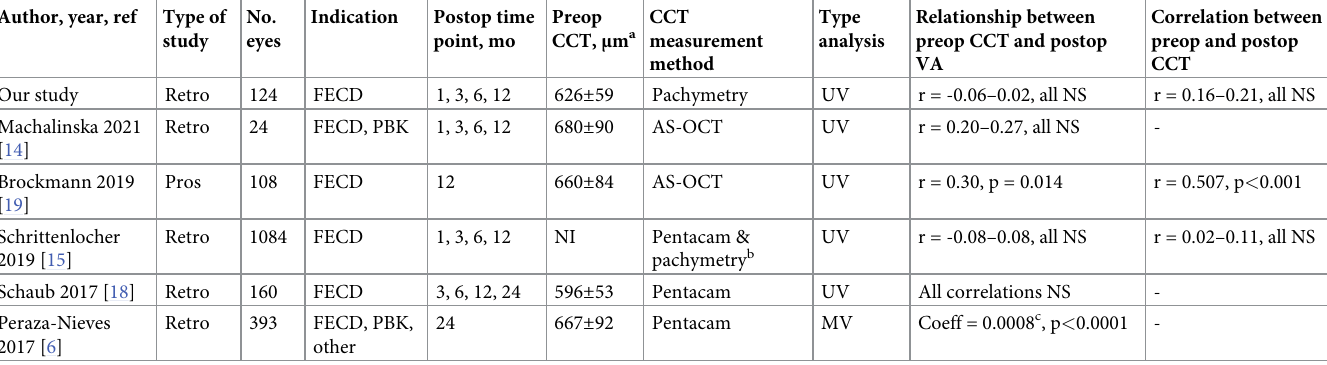
Table 1. Literature assessing the relationship between preoperative CCT and postoperative visual acuity after